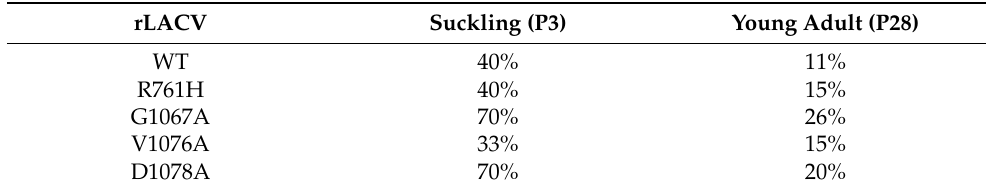
Table 1. Frequency of seizures observed in suckling and young adult mice challenged s.c. (suckling) or i.c. (young adult) with